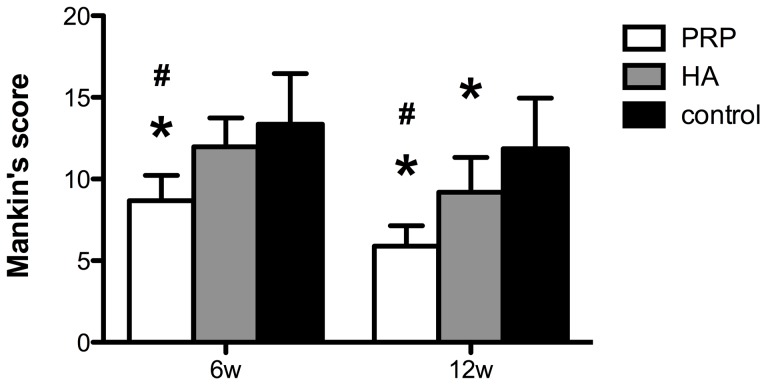
Mankin's score of the three groups at 6 w and 12 w.The score of the PRP group was lower than the other two groups at both time points. * denotes statistically significant difference compared with the control group(p<0.05). # denotes statistically significant difference compared with the HA group(p<0.05).